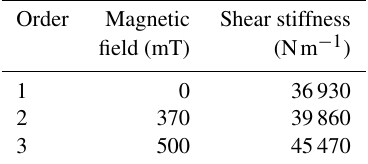
Table 2. Shear stiffness with different external magnetic fields.